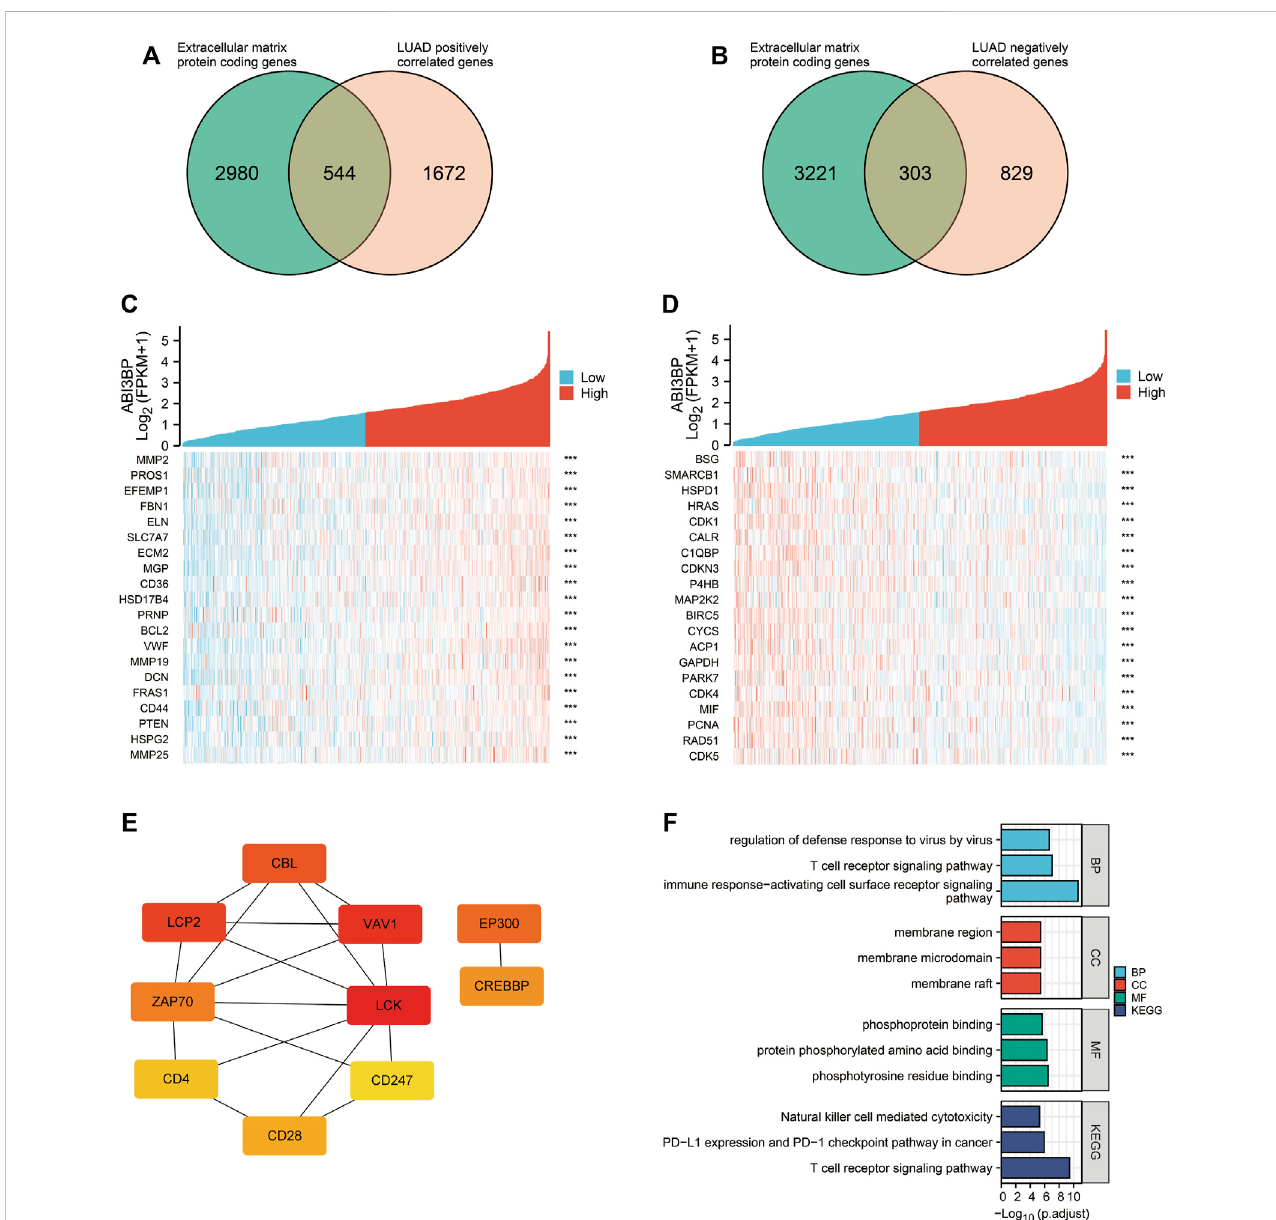
FIGURE 5 Analysis of co-expression network of ABI3BP gene in LUAD. (A) Venn diagram of genes intersection of the Extracellular matrix protein coding genes and ABI3BP positively correlated genes. (B) Venn diagram of genes intersection of the Extracellular matrix protein coding genes and ABI3BP negatively correlated genes. The top 20 genes positively (C) and negatively (D) related with ABI3BP. (E) Identi fi cation of the hub genes. (F) GO & KEGG enrichment analysis of the hub genes in